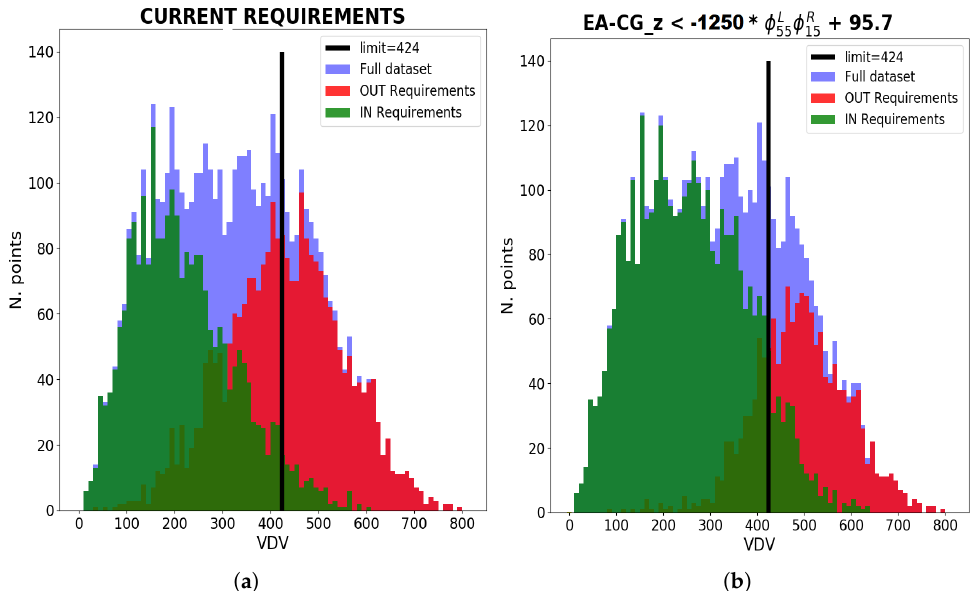
Figure 8. Specificity tests for the ( a ) benchmark and ( b ) new requirements with q = 95.7 in relation to the limit-VDV.